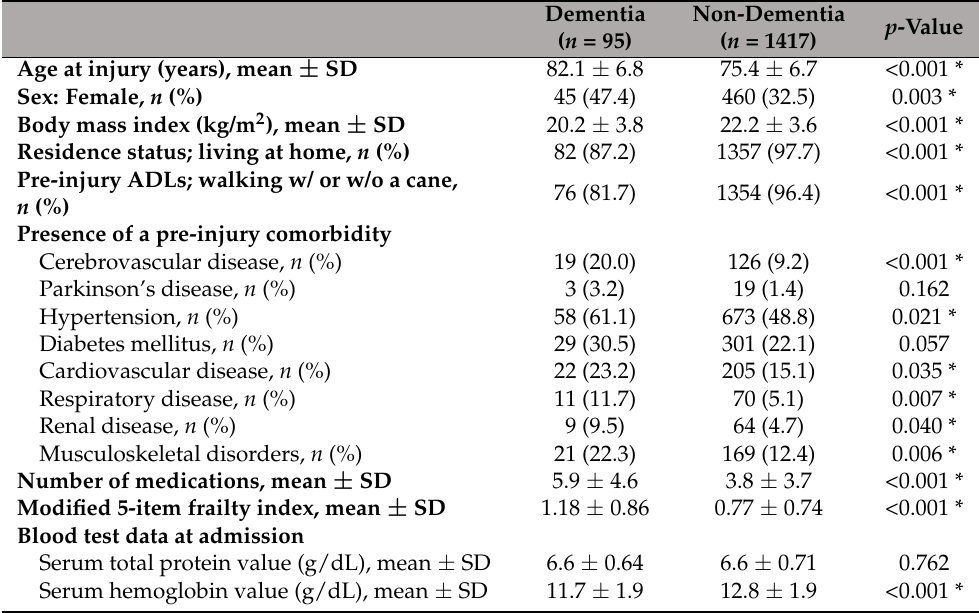
Table 1. Comparison of the patient demographics between the dementia and non-dementia groups.